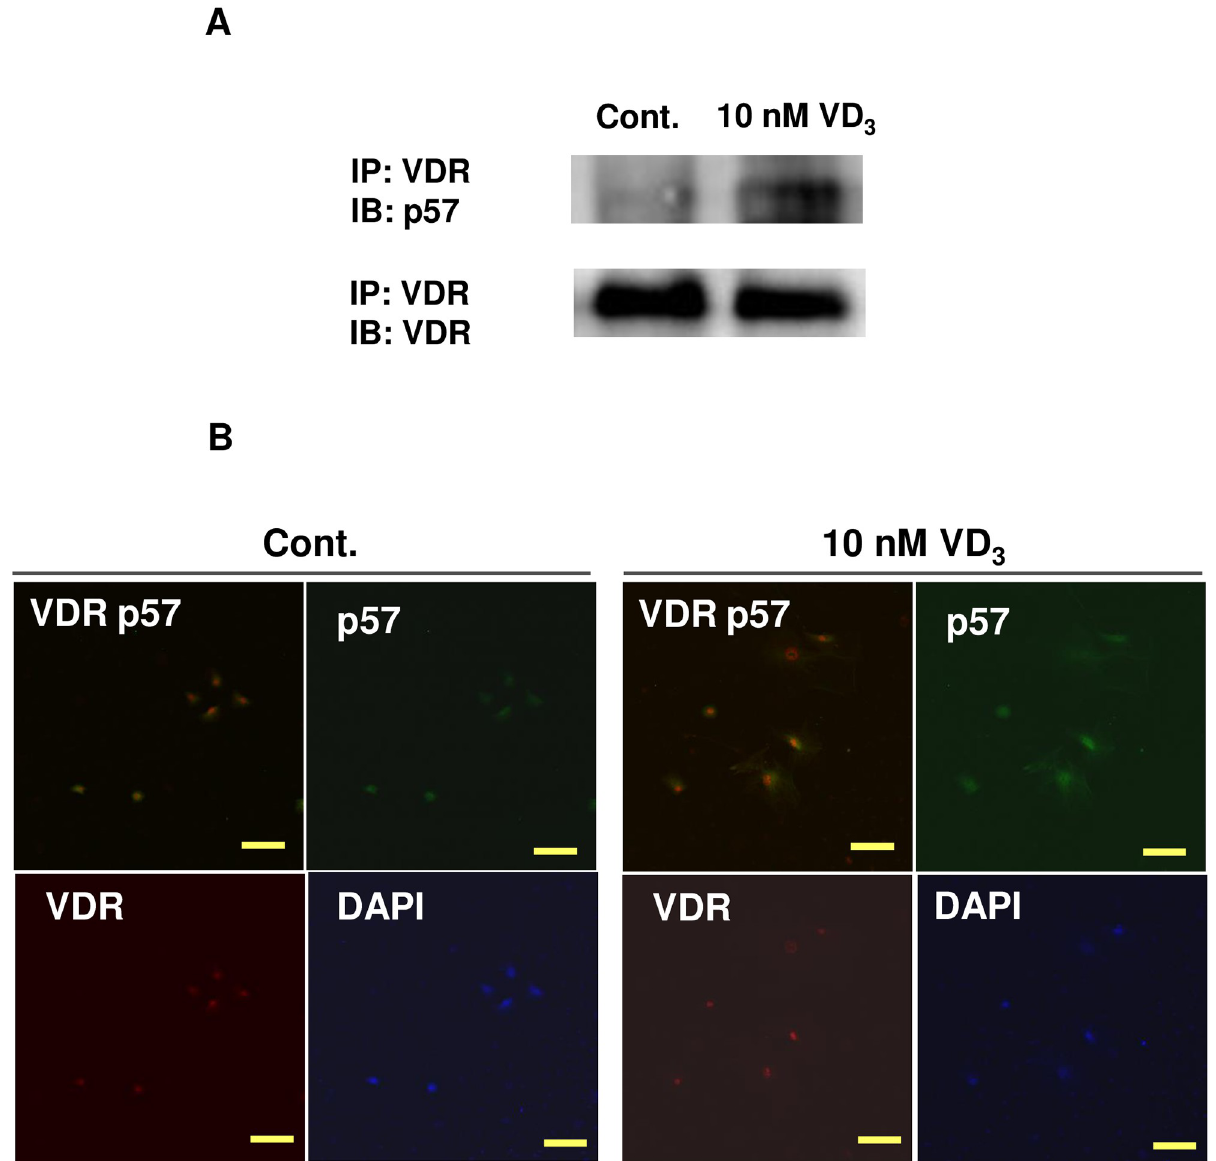
Fig 1. The association of p57 Kip2 with VDR is dependent on 1,25-(OH) 2 VD 3 . A. The association of p57 Kip2 with VDR is dependent on 1,25- (OH) 2 VD 3 in primary p57+/+ osteoblasts. Top photo: immunoprecipitation (IP) was performed with an anti-VDR antibody, and immunoblotting (IB) was conducted with an anti-p57 Kip2 antibody. Bottom: immunoprecipitation and immunoblotting were performed with an anti-VDR antibody. B. Immunofluorescence staining of primary mouse osteoblasts that were treated with 10 nM 1,25-(OH) 2 VD 3 for 24 h. Blue indicates DAPI-stained nuclei, red indicates VDR, and green indicates p57 Kip2 . The scale bar represents 100 μ